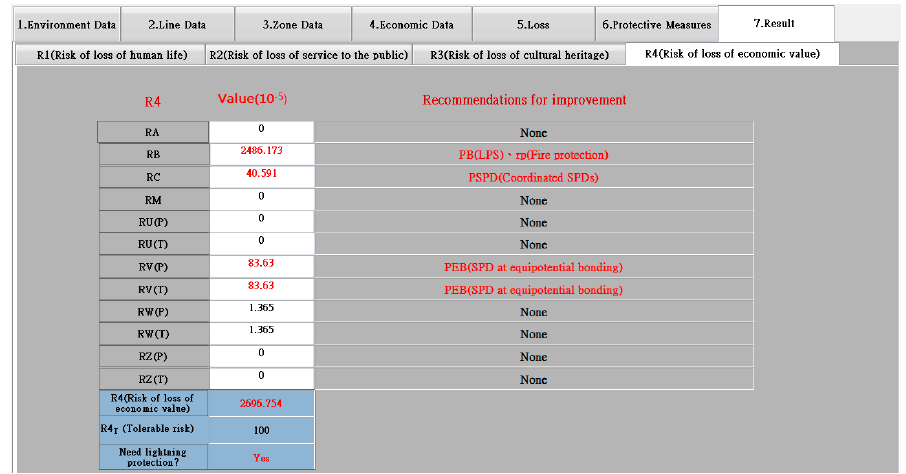
Figure 7. The risk of economic value (R4).